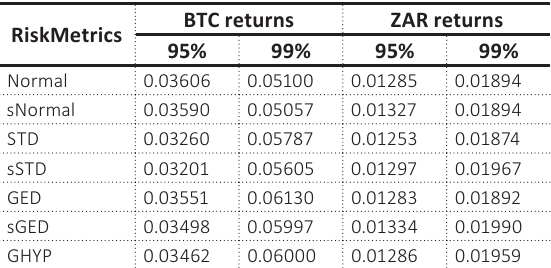
Table 5. VaR estimates